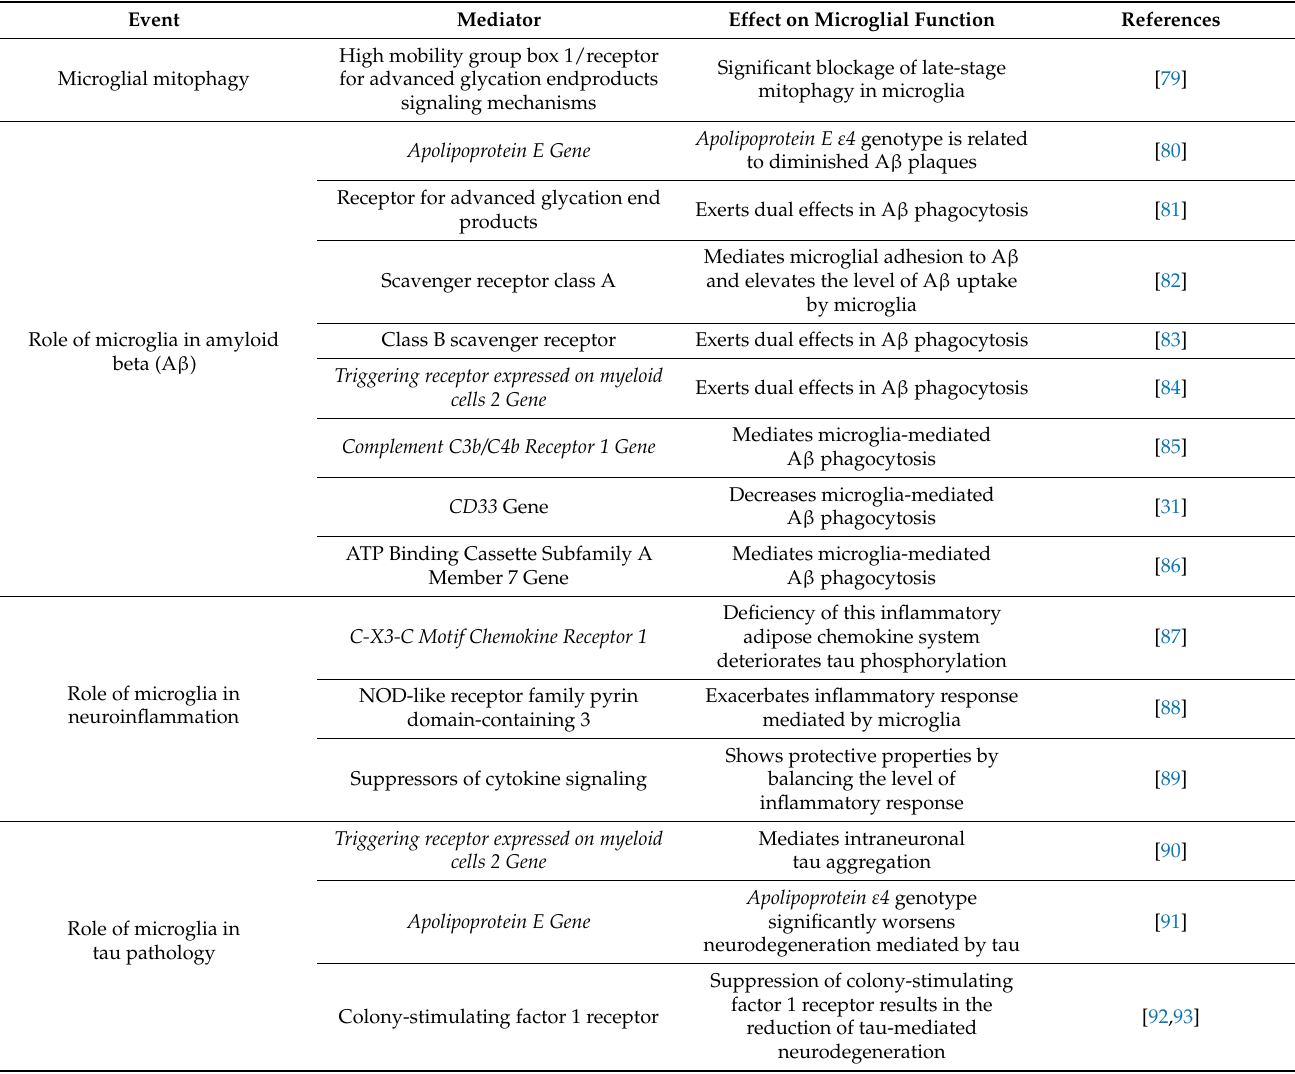
Table 2. The protective and pathological roles of microglia in AD pathogenesis